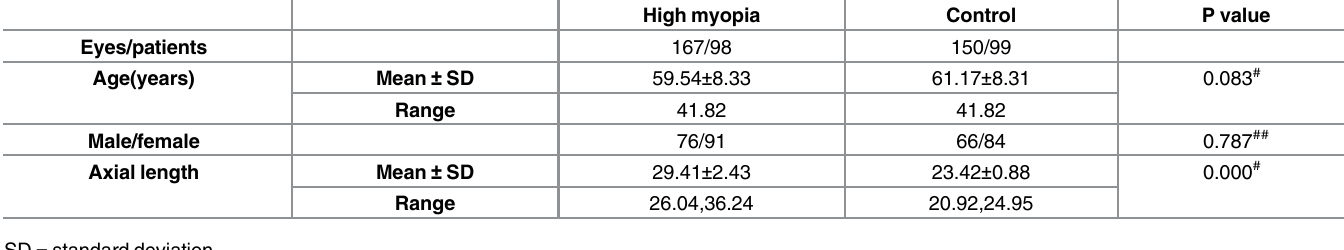
Table 1. Demographics of the study population.